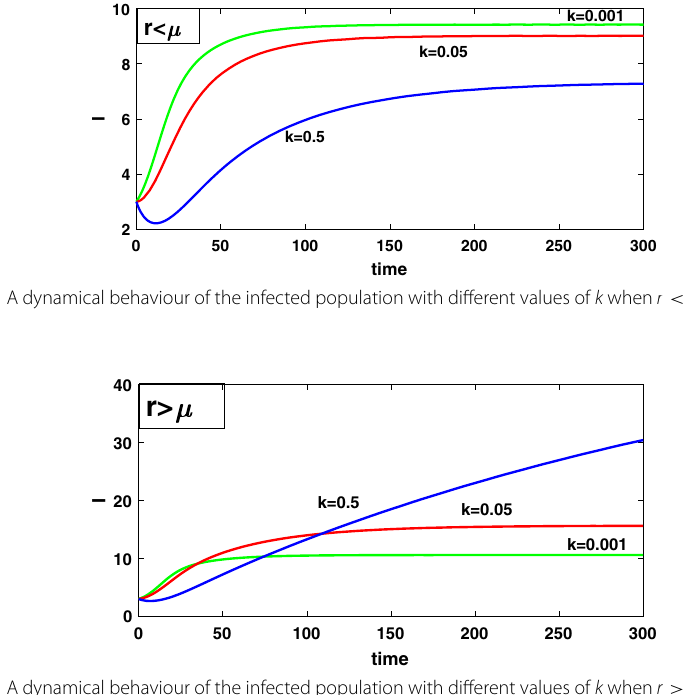
Fig. 11 A dynamical behaviour of the infected population with different values of k when r >